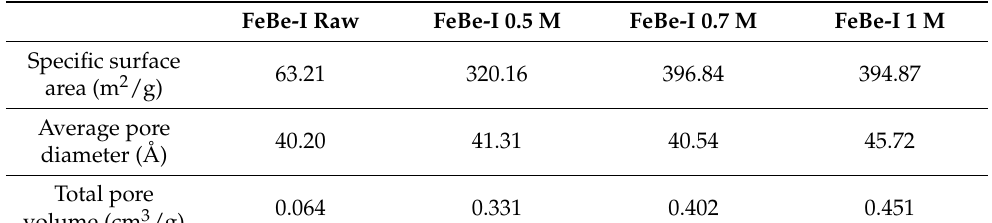
Table 3. Specific surface area and porosity of raw and activated FeBe-I (80 ◦ C; acid concentrations of 0.5 M, 0.7 M and 1 M; 2% of pulp density).